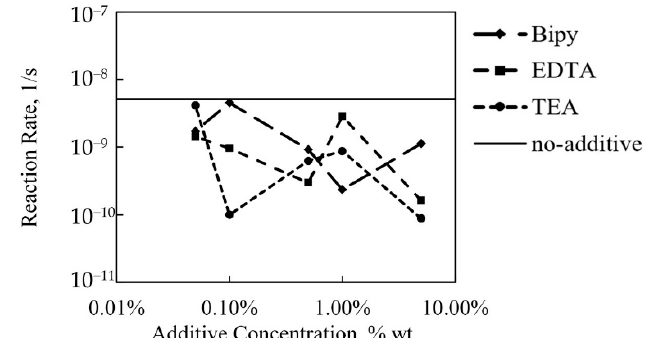
Figure 11. Arrhenius reaction rates calculated using the data in Figure 9 and a temperature of 348 K.